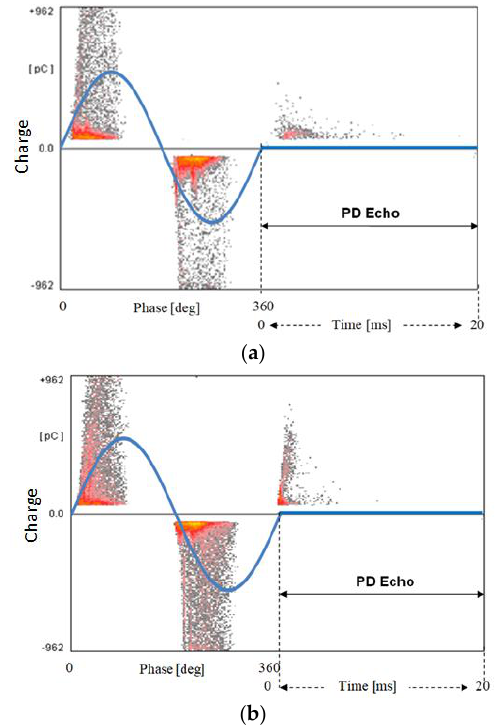
Figure 7. The PD pattern recorded in the chopped sequence with an introduced delay time t d = 160 ms ( ff = 1:4), in void embedded in thermosetting insulation, at ( a ) 11kV 1.7 U 0 , and ( b ) at 15kV 2.4 U 0 . ( ff = 1:4), in void embedded in thermosetting insulation, at ( a ) 11kV 1.7 U